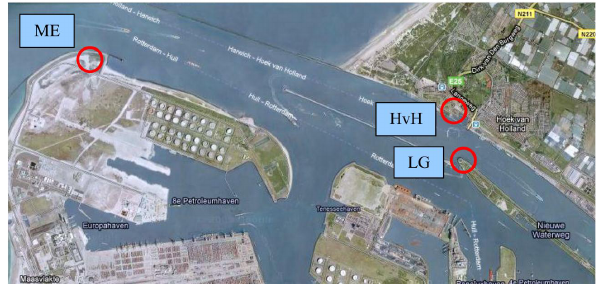
Fig. 3. Map of the measurement area, with marks at the 3 mea- surement sites. HvH – Hoek van Holland, LG – Landtong, ME – Maasvlakte.